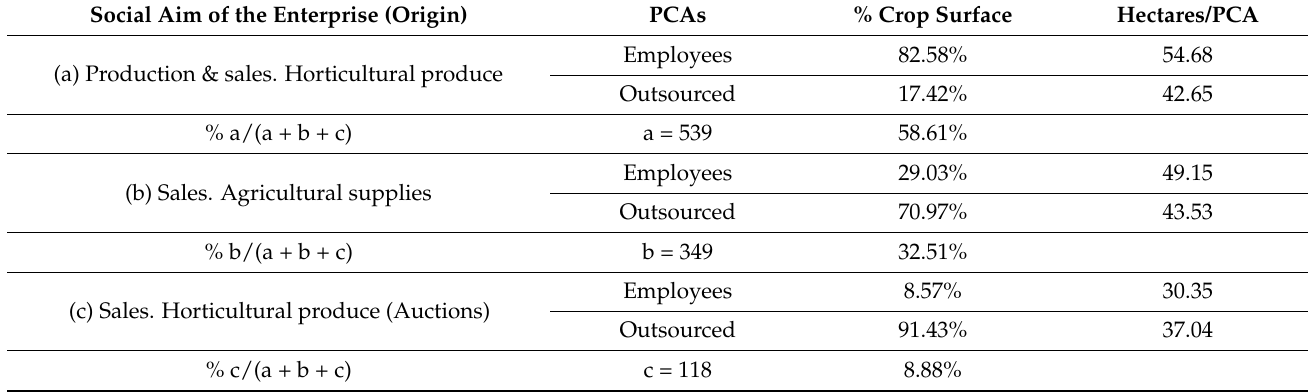
Table 2. Chart reflecting the human resources used in the provision of technical assessment between the period